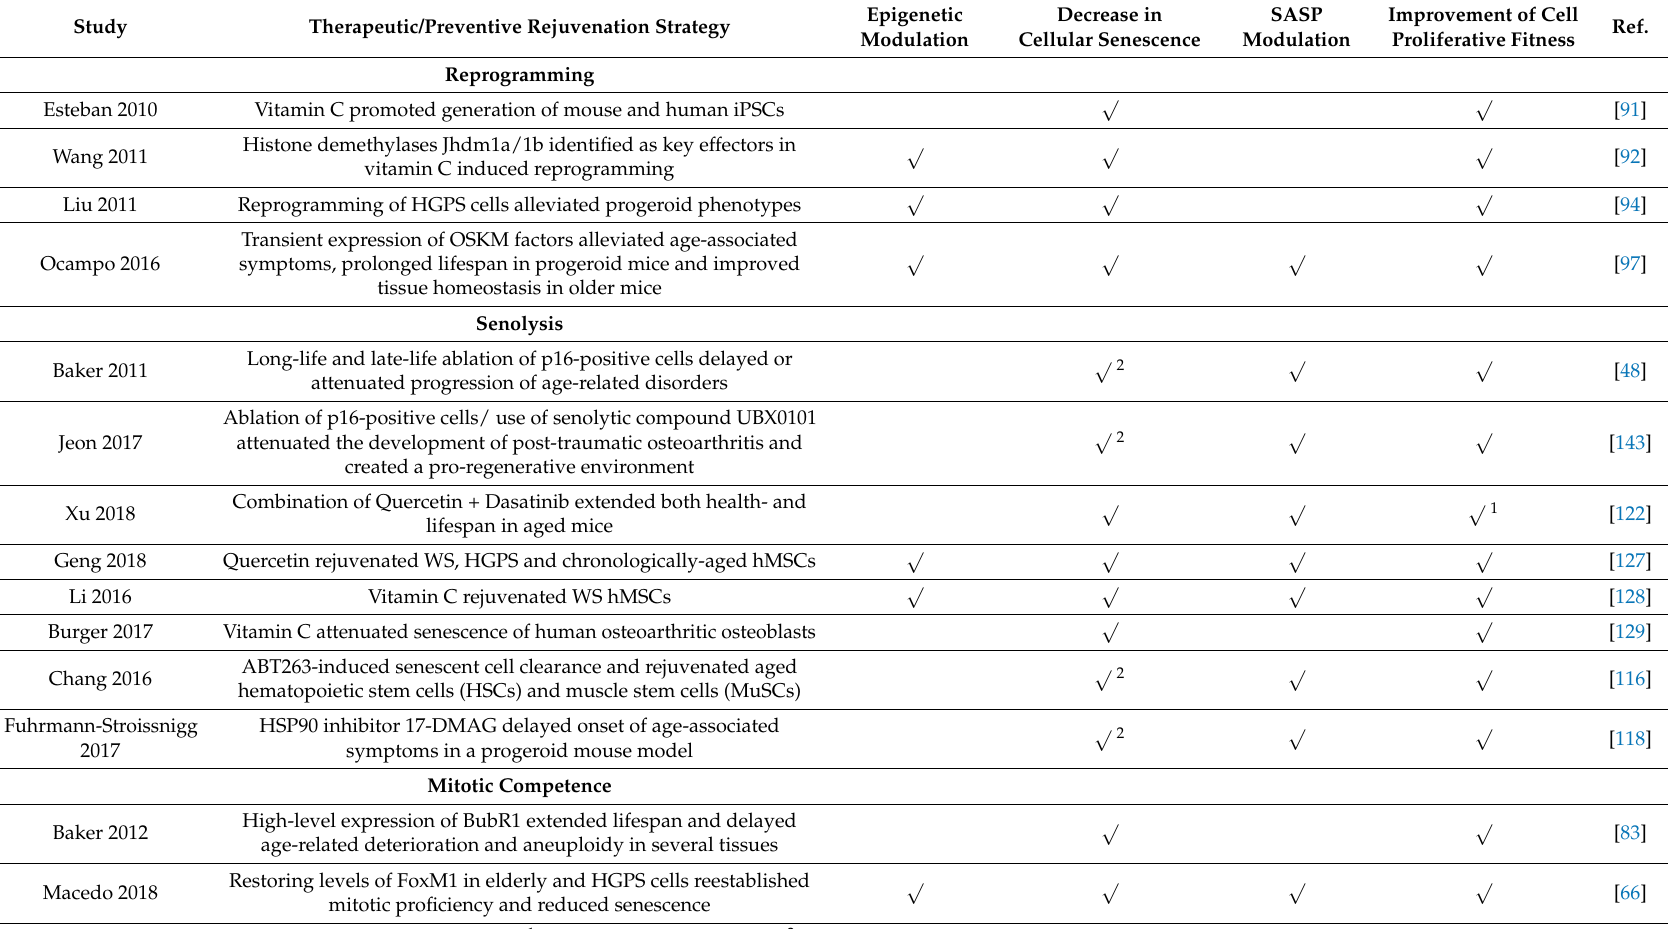
Table 1. Studies reporting aging therapeutic/preventive strategies that show improvement of cell proliferative